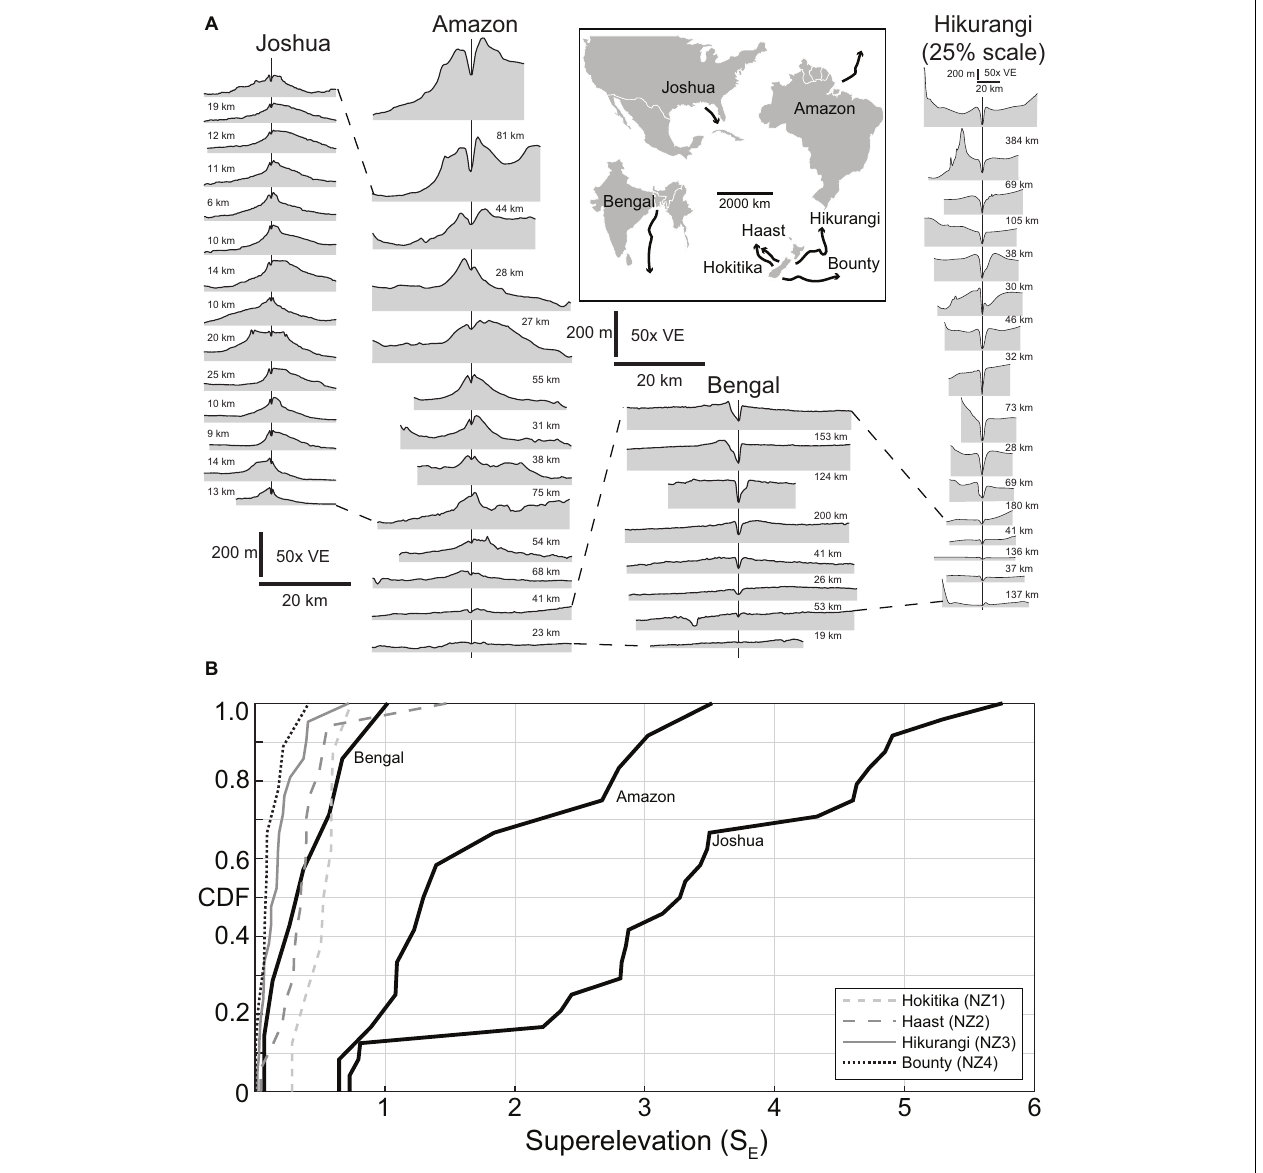
FIGURE 8 | Submarine channels on the modern seafloor show variable superelevation. (A) Cross-sections of modern submarine channels (inset map for location). Dashed lines indicate approximately equivalent streamwise portions of the four channels based on normalized channel length. Distance between each cross-section shown in kilometers. (B) Calculated superelevation values indicate that passive-margin channels commonly attain higher superelevation, perhaps due to development of an equilibrium profile and strong channel-floodplain coupling. Note that the studied portion of the Bengal channel is quite distal (see A ), and thus not highly superelevated. The Hikurangi channel and other active-margin channels around New Zealand cannot build an equilibrium profile and thus display weak channel-floodplain coupling, with little levee development and thus low values of